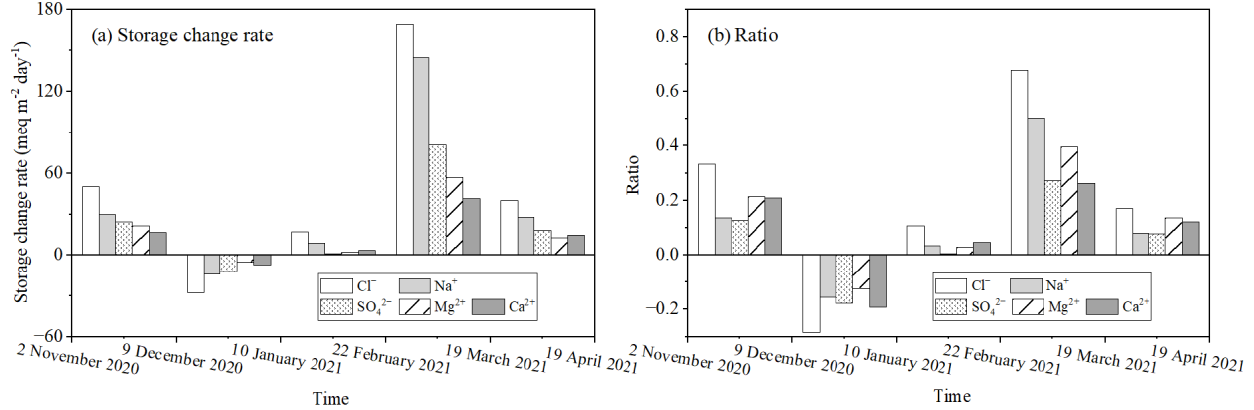
Figure 7. Migration characteristics of soluble ions during the freeze – thaw process: ( a ) Storage change rate; ( b ) Ratio.